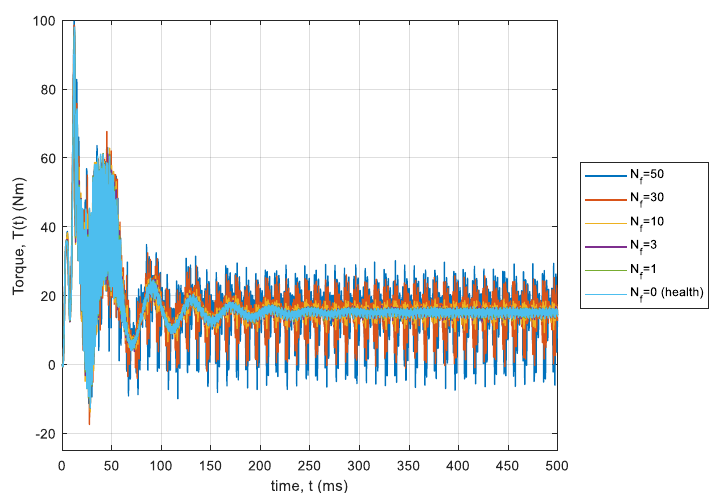
Figure 5. Torque waveforms of a faulty (N f = 1–50) as well healthy (N f = 0) motor without external torque (T L = 0 Nm).